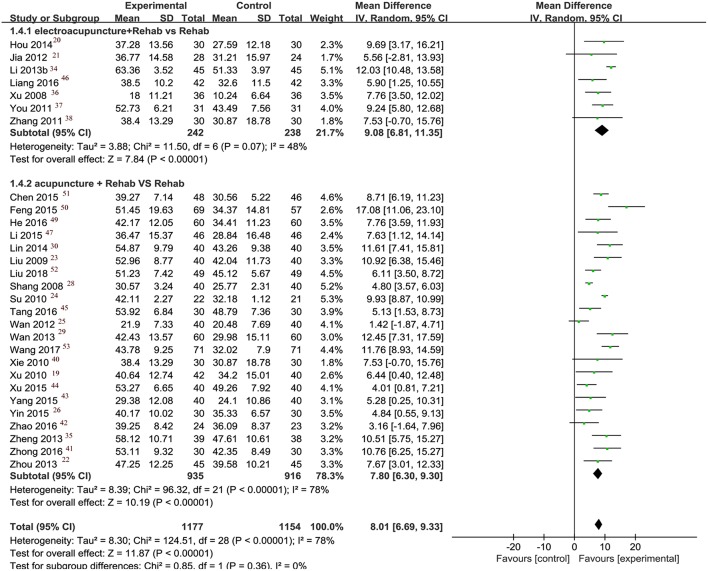
Forest plot of FMA.